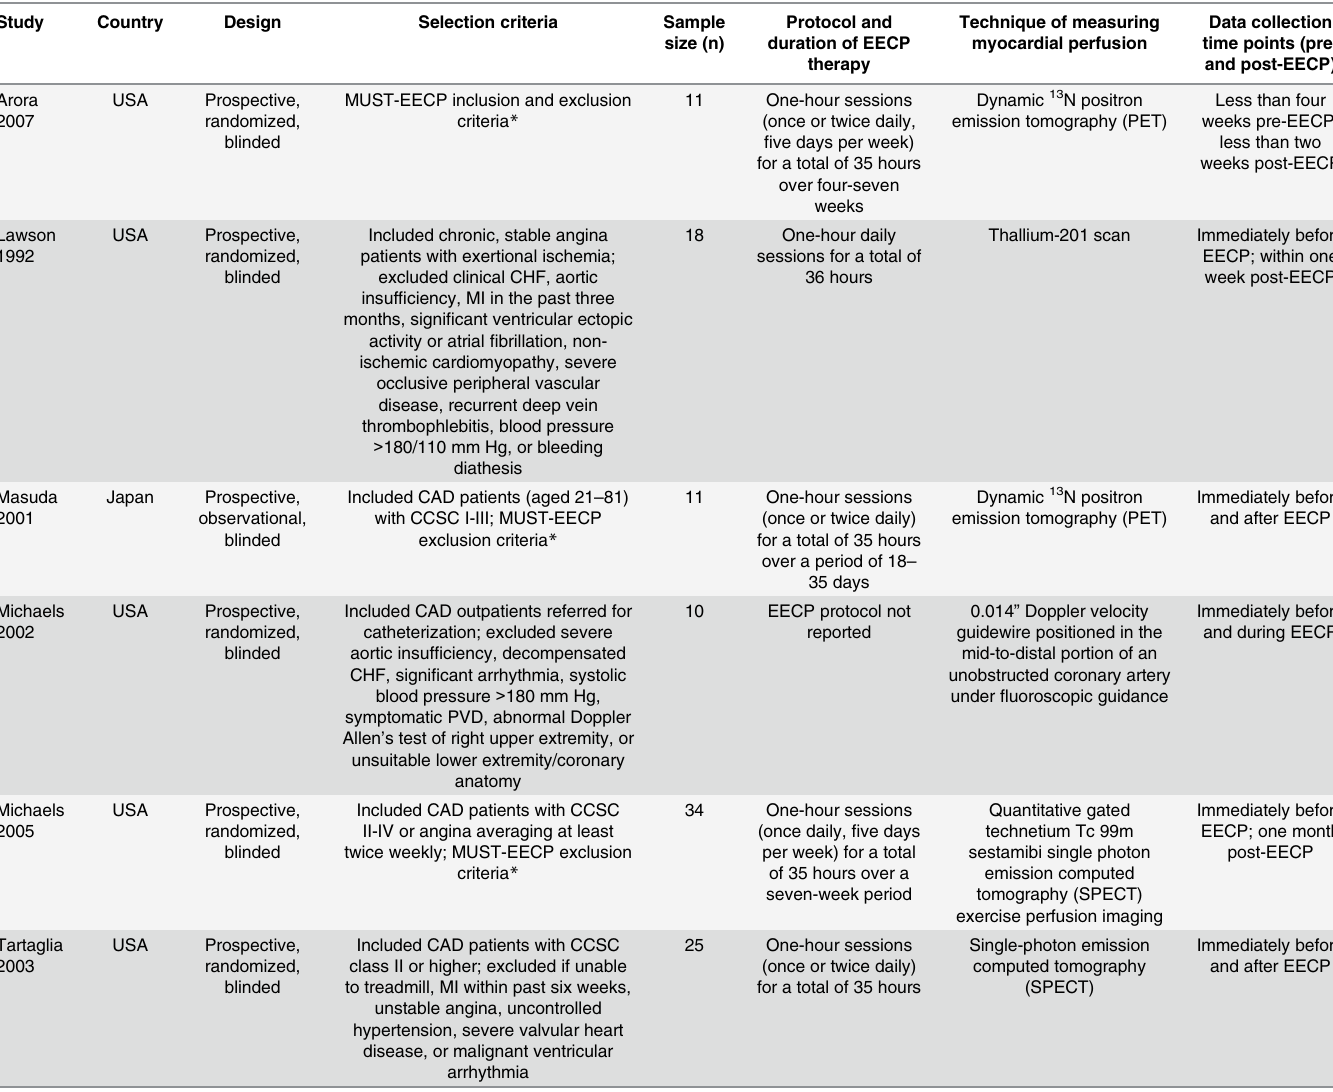
Table 1. Characteristics of Included